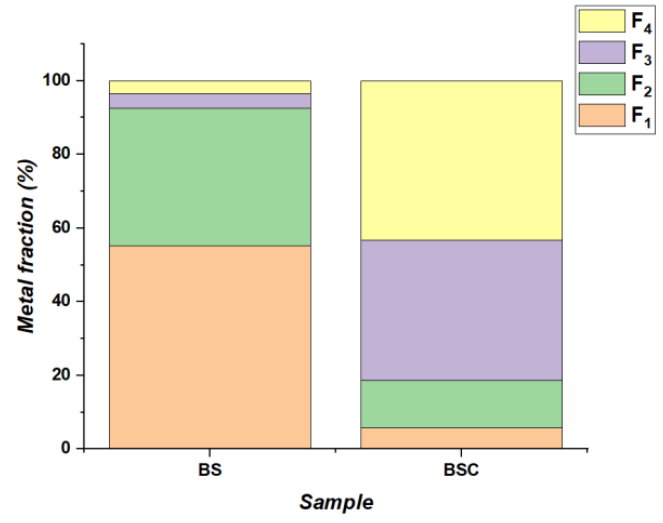
Figure 6. Fractions of metals in biosolid (BS) and biosolid char (BSC) samples.